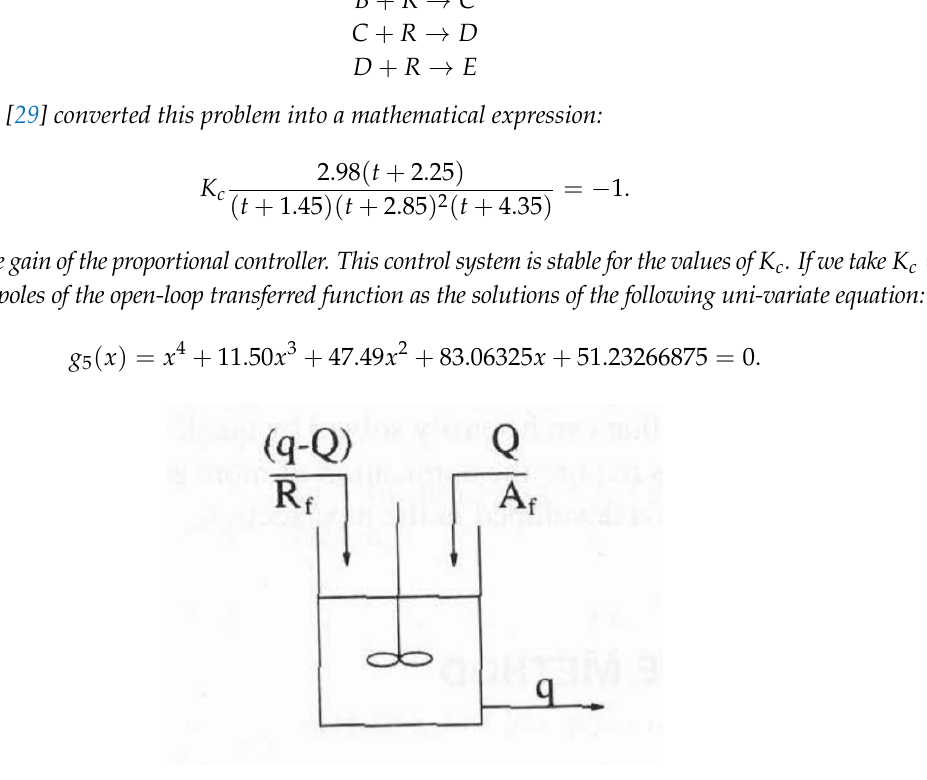
Figure 1. Continuous stirred tank